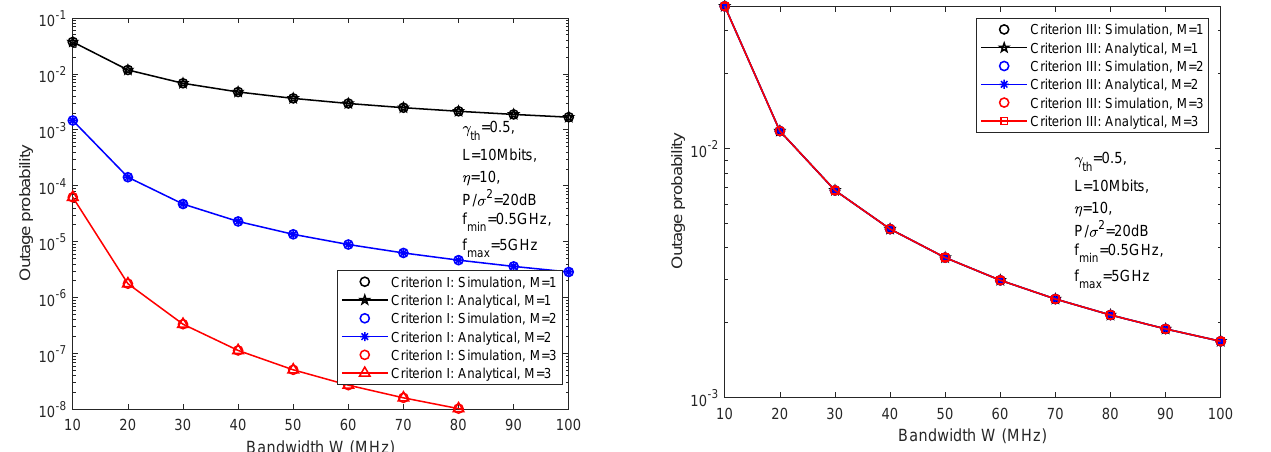
Figure 5. Outage probability versus bandwidth W for criterion I.